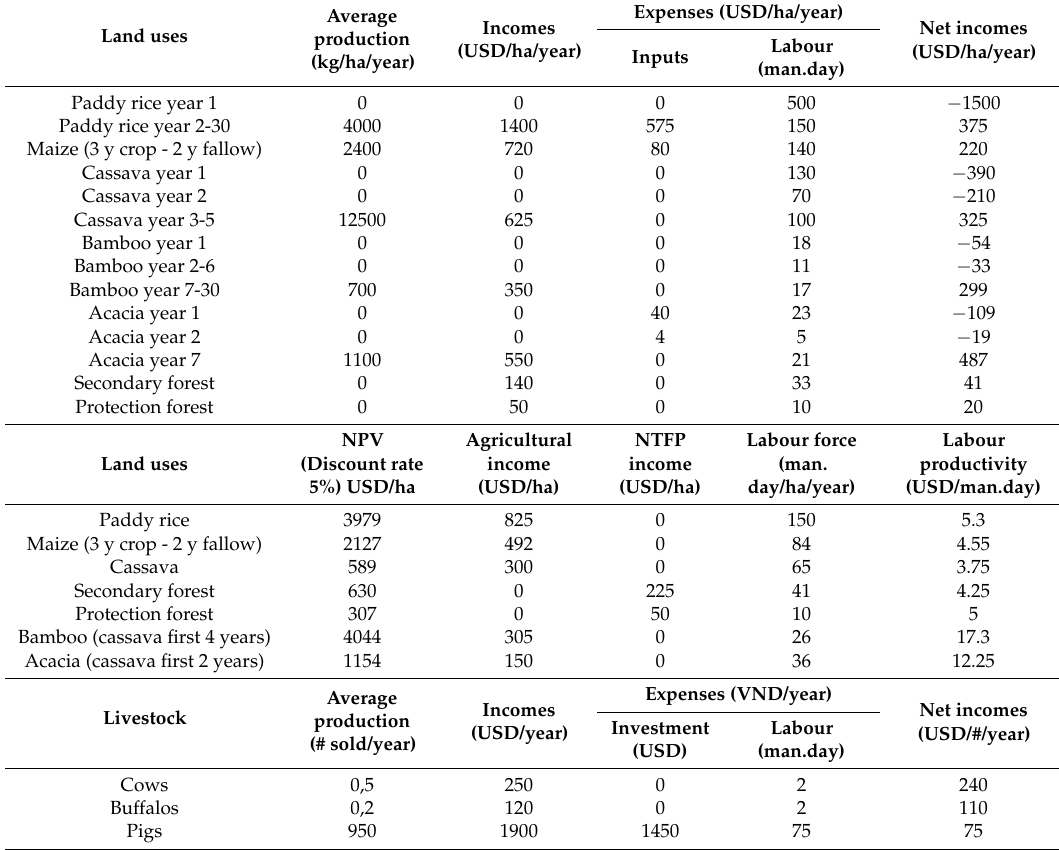
Table A1. Economic calculations per land use type; based on focus group discussions and survey of 50 households.